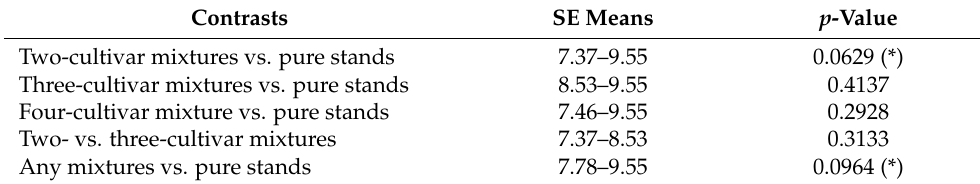
Table 4. Results of orthogonal contrasts between grain yield variability in the different types of lentil canopies (pure stands or mixture types), expressed in terms of the standard error of the mean (see text for further explanation). Contrasts SE Means p -Value Two-cultivar mixtures vs. pure stands 7.37–9.55 0.0629 (*) Three-cultivar mixtures vs. pure stands 8.53–9.55 0.4137 Four-cultivar mixture vs. pure stands 7.46–9.55 0.2928 7.37–8.53 0.3133 7.78–9.55 0.0964